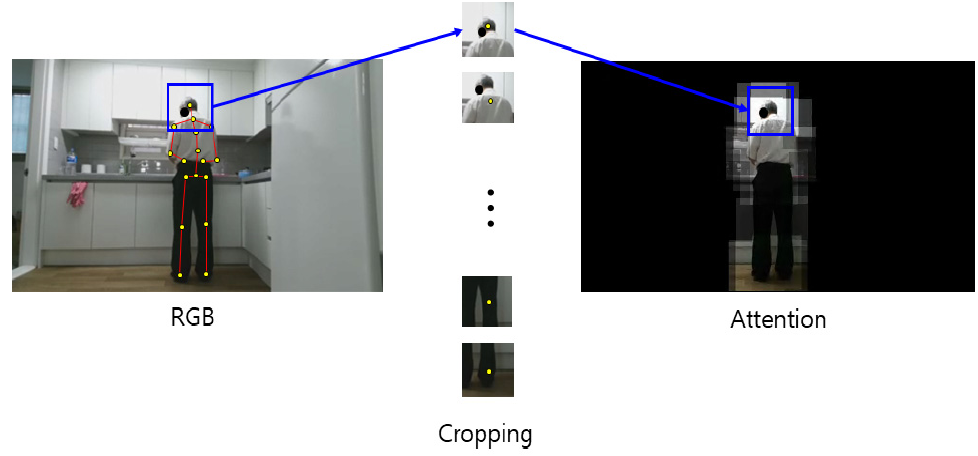
Figure 9. Body region of interest (ROI) extraction process of RGB video using the skeleton.